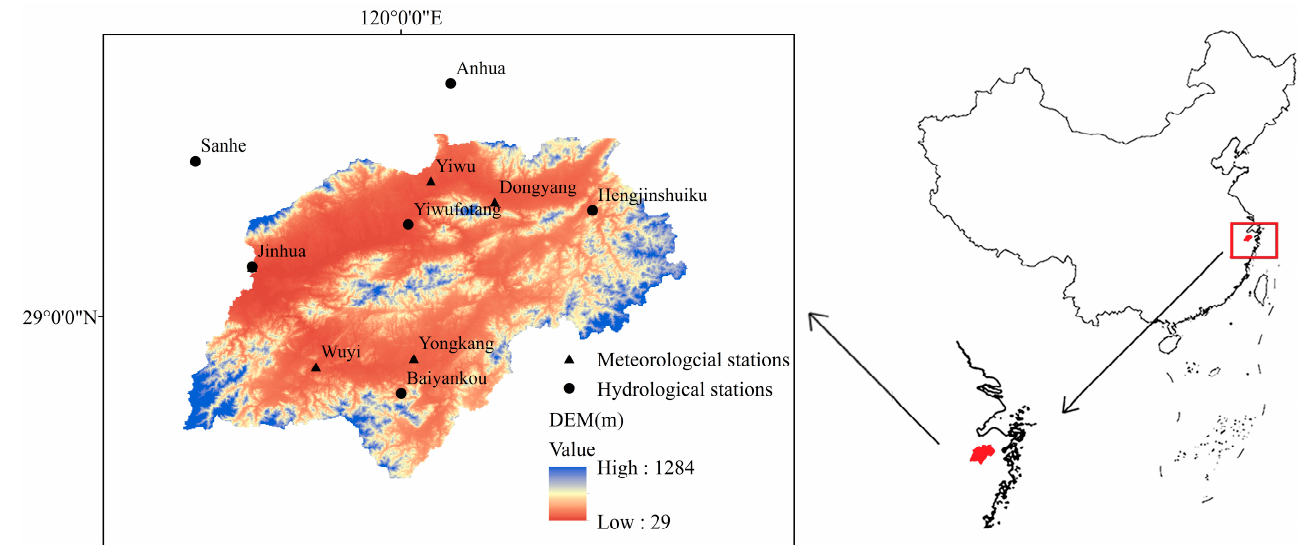
Figure 1. The Jinhua River Basin and location of meteorological and hydrological stations used in this study.